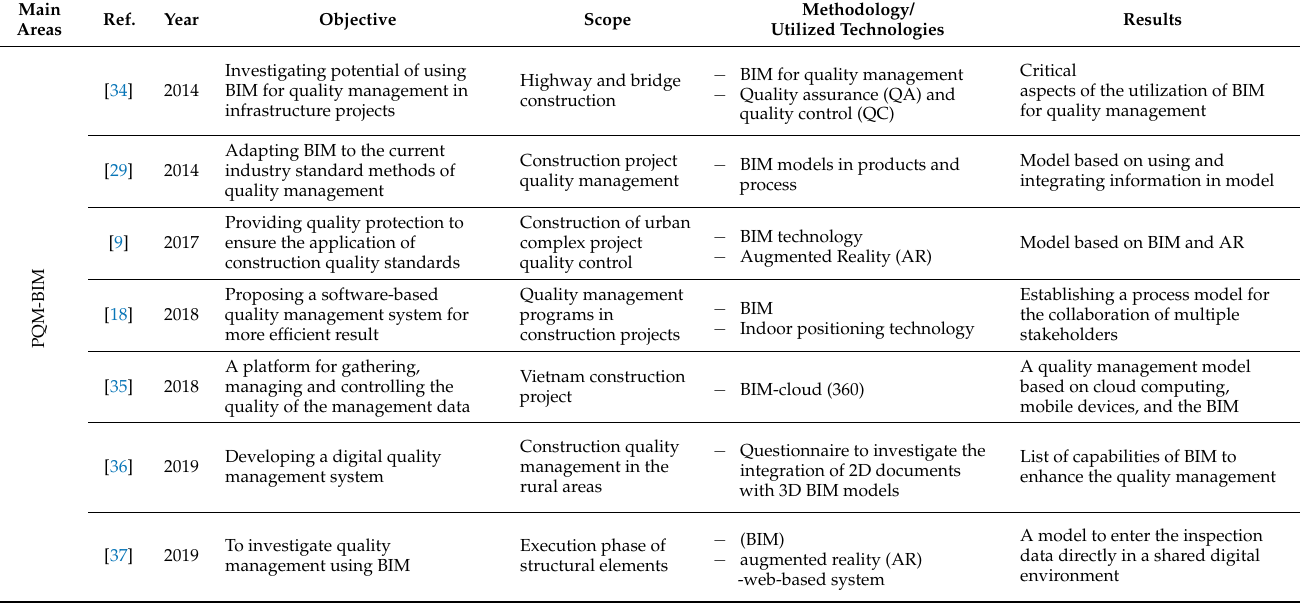
Table 1. Comparative study of previous PQM-BIM-UAV research and the current investigation. Main